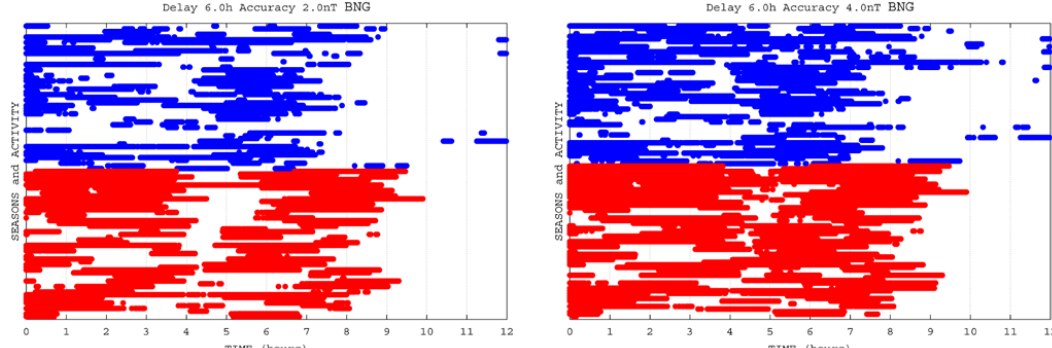
Fig. 11. Time table for BNG data, with t 0 =6h, α =2nT (left panel) and α =4nT (right panel) periods for the B 1 (t) . Note the distinction between subsets D i and Q i : blue lines for disturbed days, red lines for quiet days. Yearly variation reads from top to down (starting with the first five days from January, up to the last five days of December, separately for D i and Q i sets).